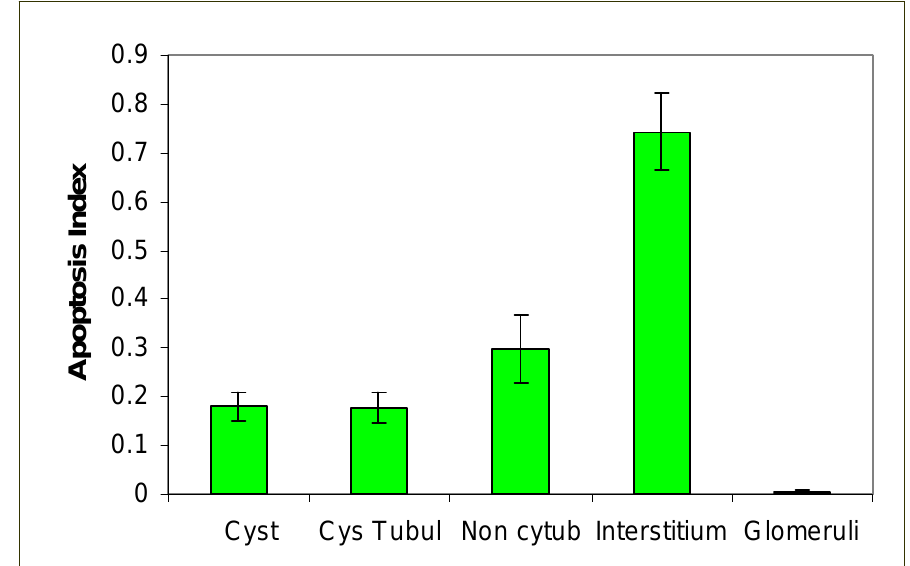
FIGURE 3 The AI of ADPKD sections (mean ±